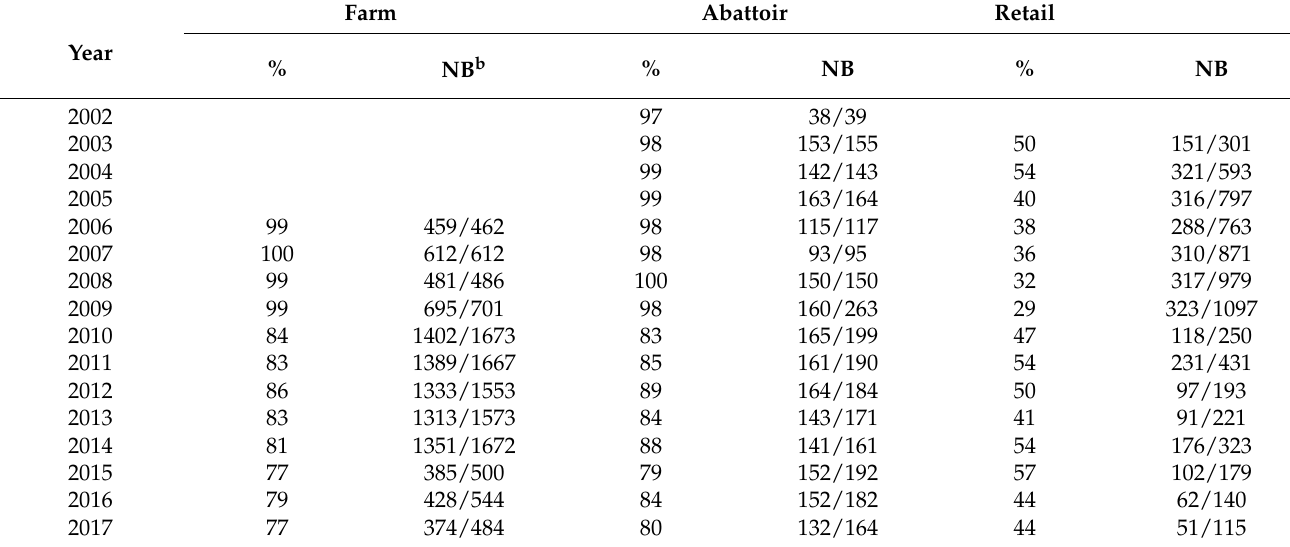
a Samples at the farm were from feces, at the abattoir from caecum material, and at the retail outlet, from chops. b NB = number of positive over the total number of samples collected. Similarly, Rahimi et al.’s study conducted in the Isfahan and Shahrekord provinces of Iran on antibiotic resistance in Shigella in meat and meat products reveals a similar pattern [127]. Incidence of antibiotic resistance is higher in raw meat than in processed meat. Nevertheless, McMahon et al. [128] demonstrated that sublethal stress processes, commonly used in food preservation, do alter antibiotic resistance. Some, such as high temperature (45 ◦ C), decrease antibiotic resistance, whereas others increase antibiotic resistance, even after removal of the stress, which suggests that the bacteria have developed an increased resistance that lasts over time. With Cronobacter sakazakii , cells stressed by desiccation (40 ◦ C for 2 h and held at 21 ◦ C for 4 d) were more sensitive to streptomycin, gentamicin, kanamycin, tetracycline, vancomycin, ampicillin, enrofloxacin and doxycycline, but less sensitive to neomycin and amoxicillin. For cold (4 ◦ C for 24 h)-stressed cells, increased sensitivity to 8 out of the 13 antibiotics tested was observed. Heat stress (55 ◦ C for 5 min) caused the greatest sensitivity increases of the five stress-inducing methods tested. Sensitivity was increased to all 13 antibiotics tested except for two out of the five strains tested for streptomycin and three for neomycin [129]. The heat stress applied by these conditions were well below the cooking temperature of processed meat, which is typically a core temperature of 71 ◦